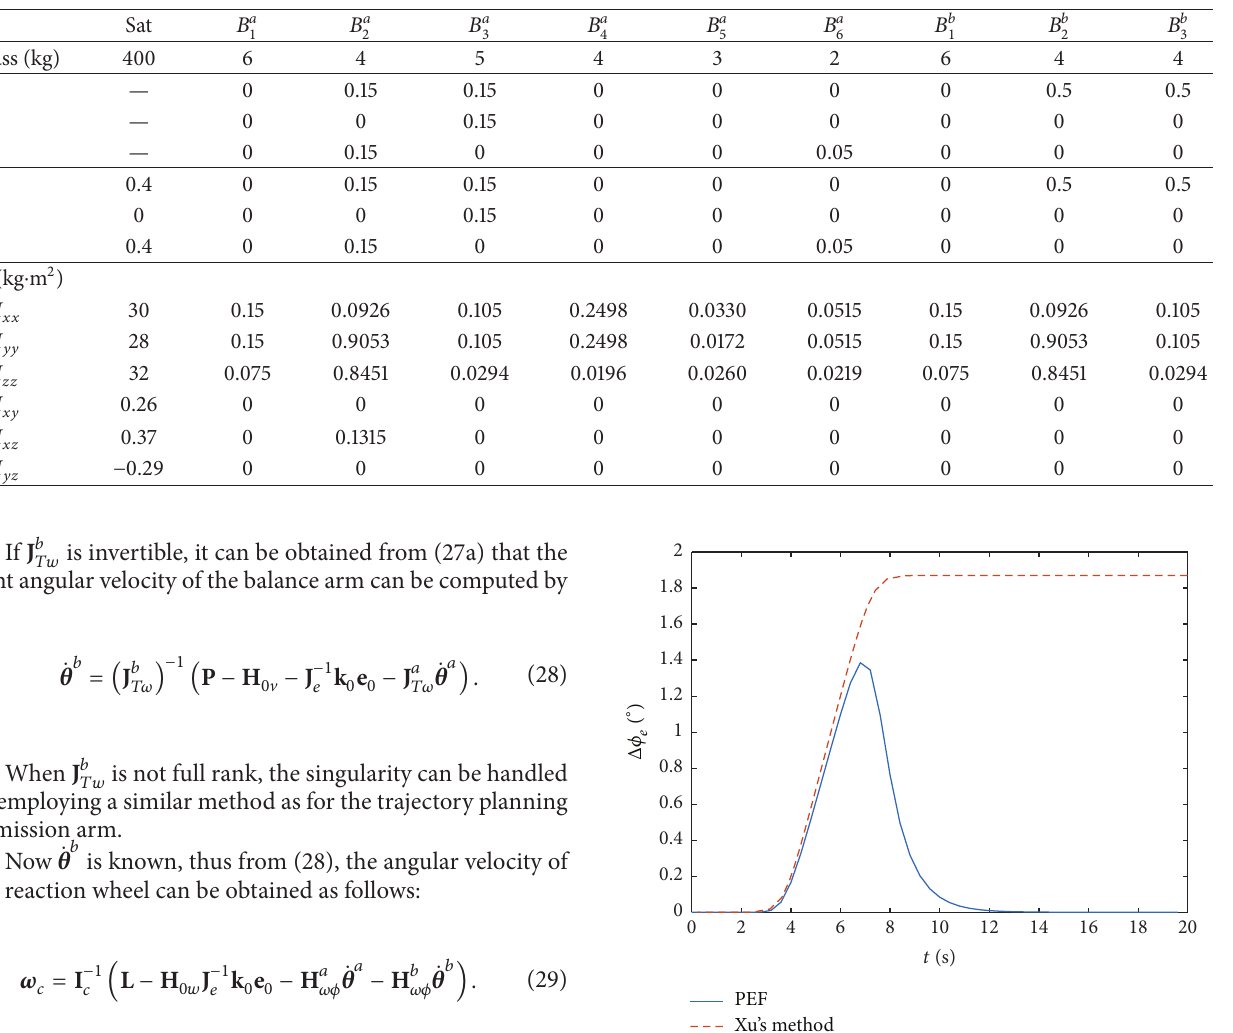
Table 1: The mass properties of satellite base, mission arm, and balance arm.